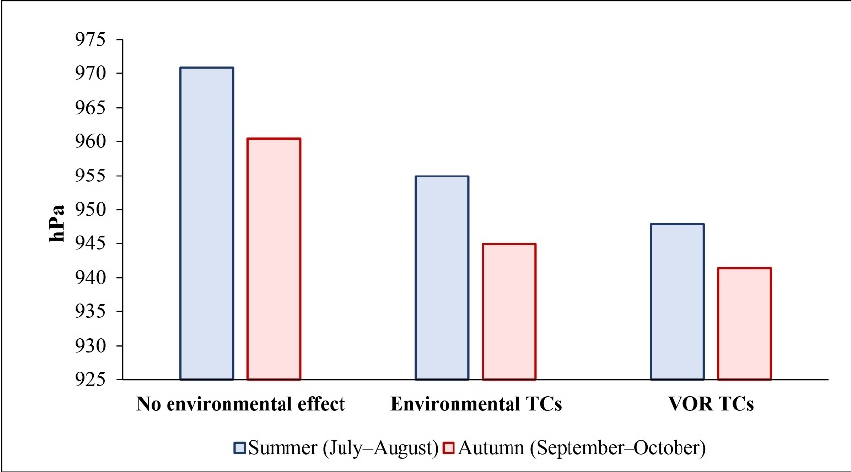
Figure 1. Average minimum sea level pressure of TCs not affected substantially by environmental factors (“No environmental effect”), Environmental TCs, and VOR TCs in summer (July–August) and autumn (September–October).